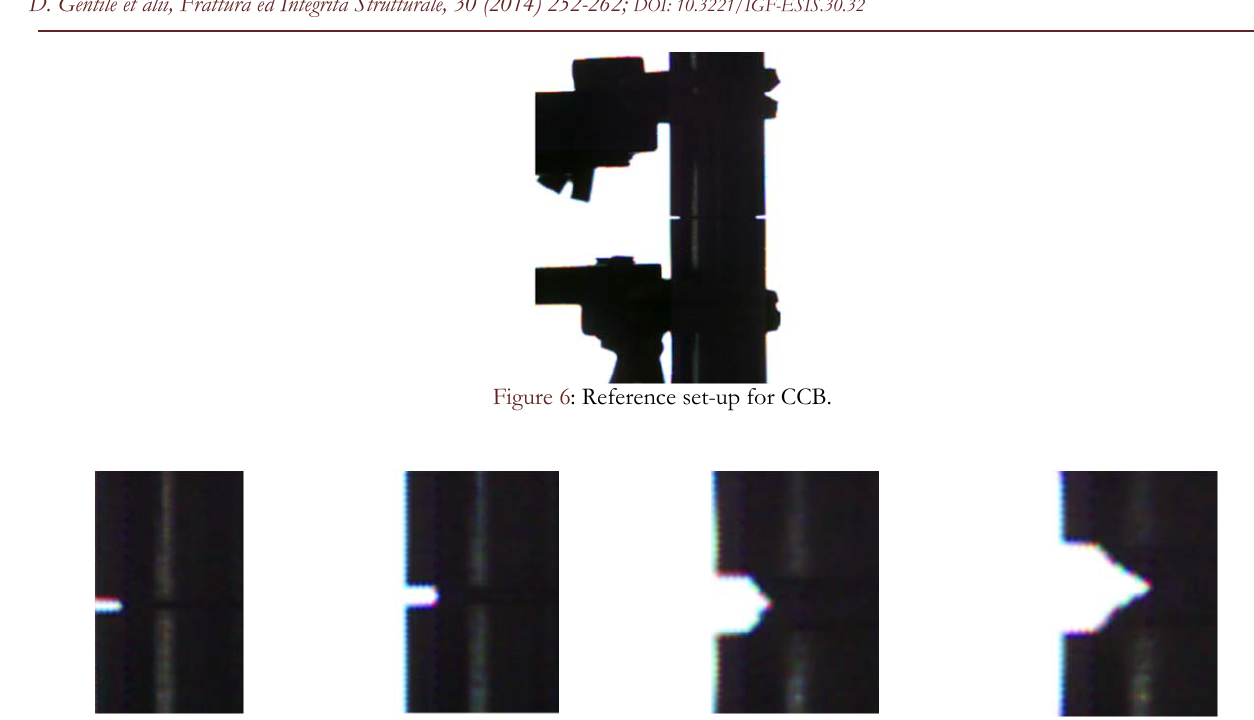
Figure 7: Sequence of crack tip blunting development and crack initiation observed with high speed camera.